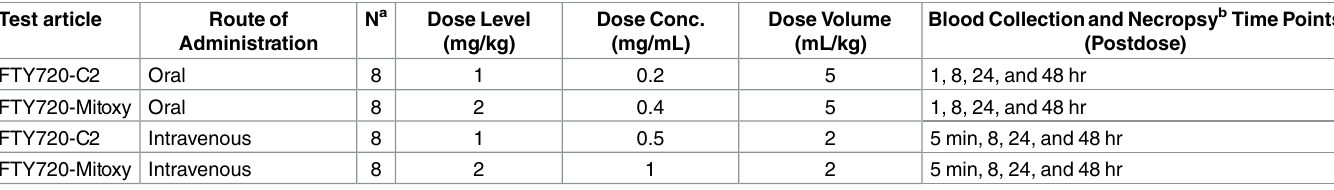
Table 2. PharmacokineticStudy Designfor FTY720-C2and FTY720-Mitoxy. Test